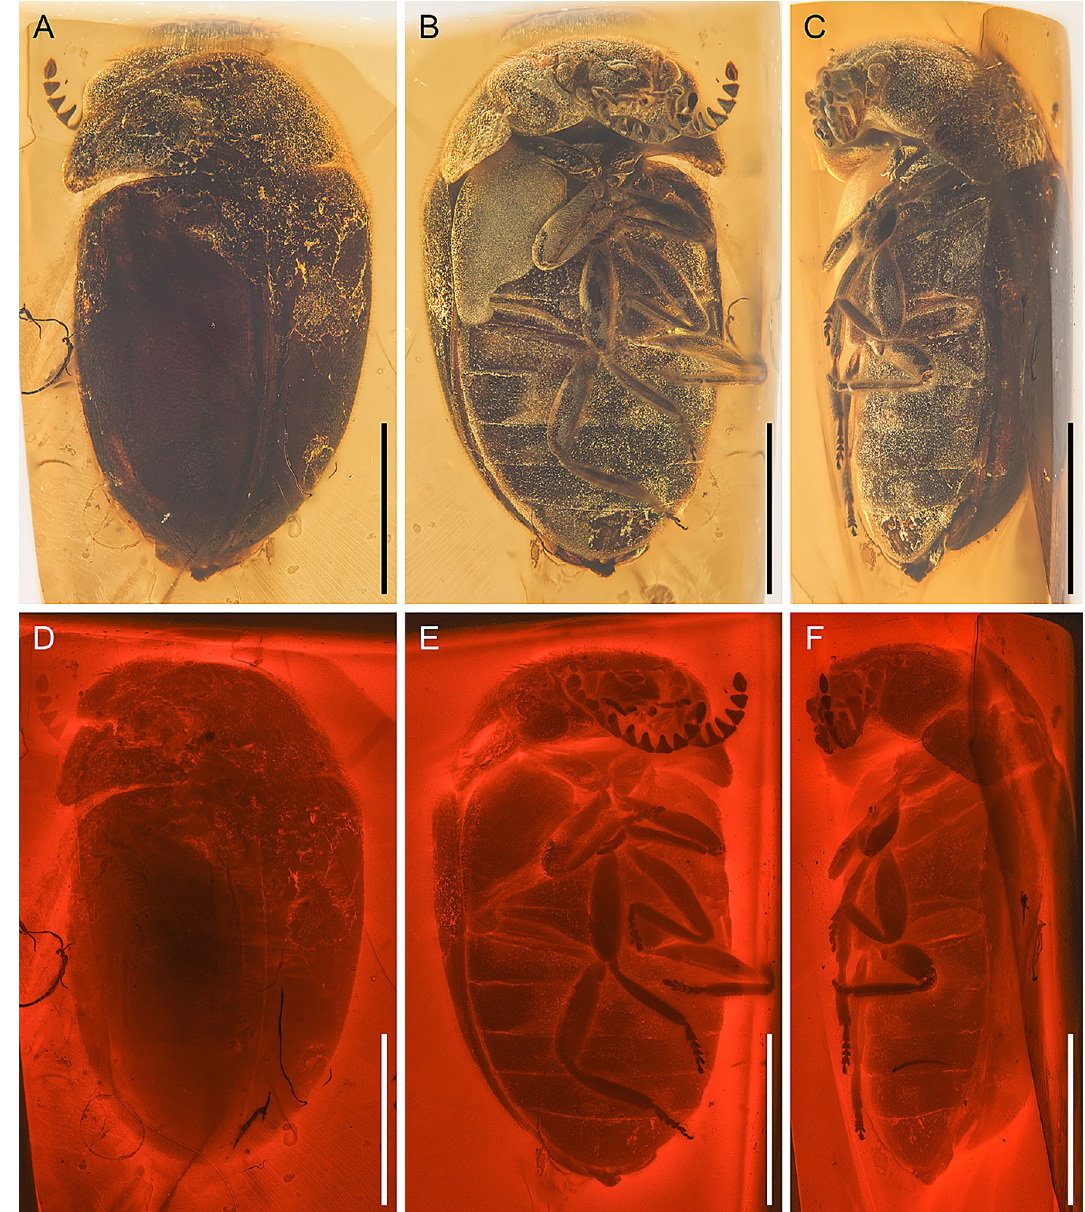
Figure 1. General habitus of Varcalium lawrencei gen. et sp. nov. , holotype, NIGP177336, under incident light ( A – C ) or widefield fluorescence ( D – F ). ( A , D ) Dorsal view. ( B , E ) Ventral view. ( C , F ) Lateral view. Scale bars: 1000